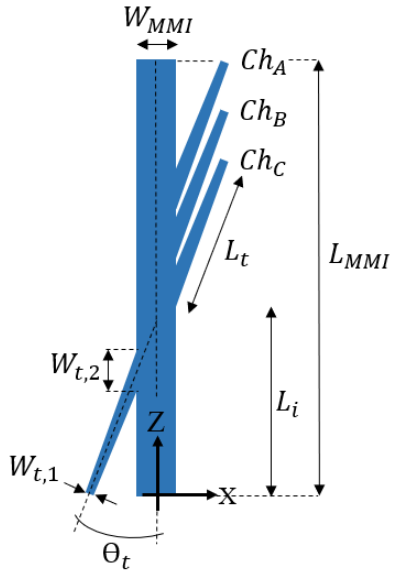
Figure 2. Schematic sketch of the 1 × 3 angled multimode interference (AMMI) demultiplexer at the x–z plane.